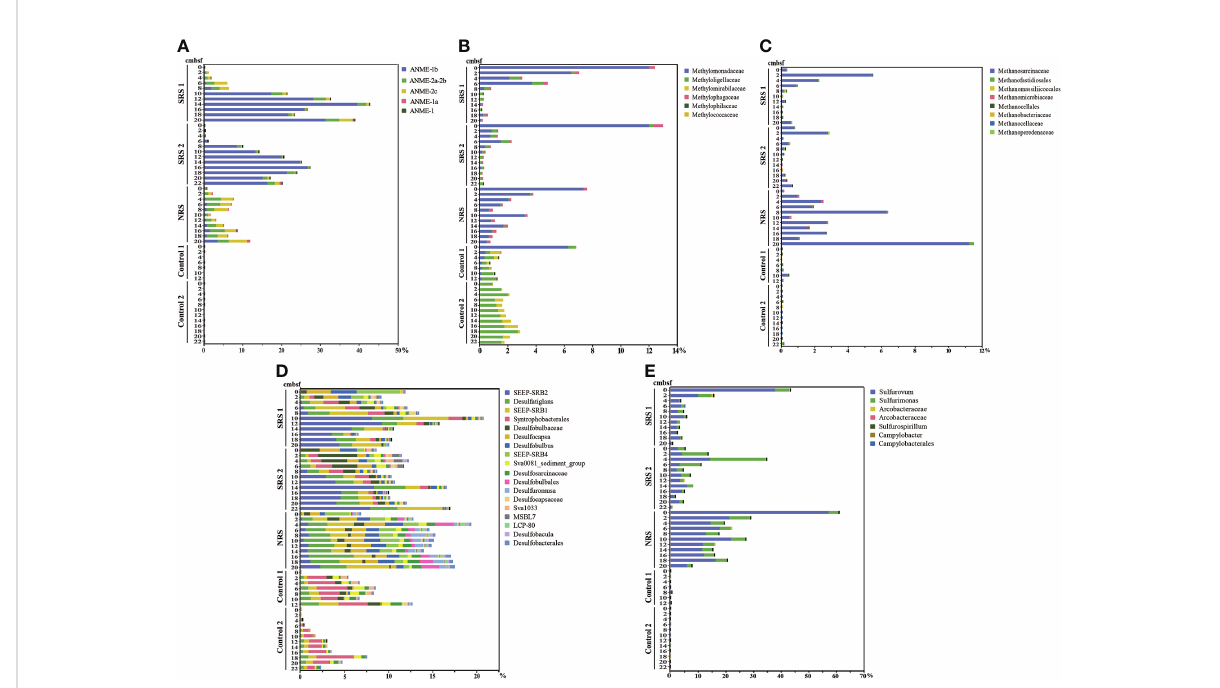
FIGURE 4 The abundances of main functional microbial groups in all samples. (A) Main genera of the ANME group. (B) Main genera of the methylotrophs group. (C) Main genera of the methanogens group. (D) Main genera of the SRB in the phylum Desulfobacterota . (E) Main genera of the SOB in the phylum Campylobacterota